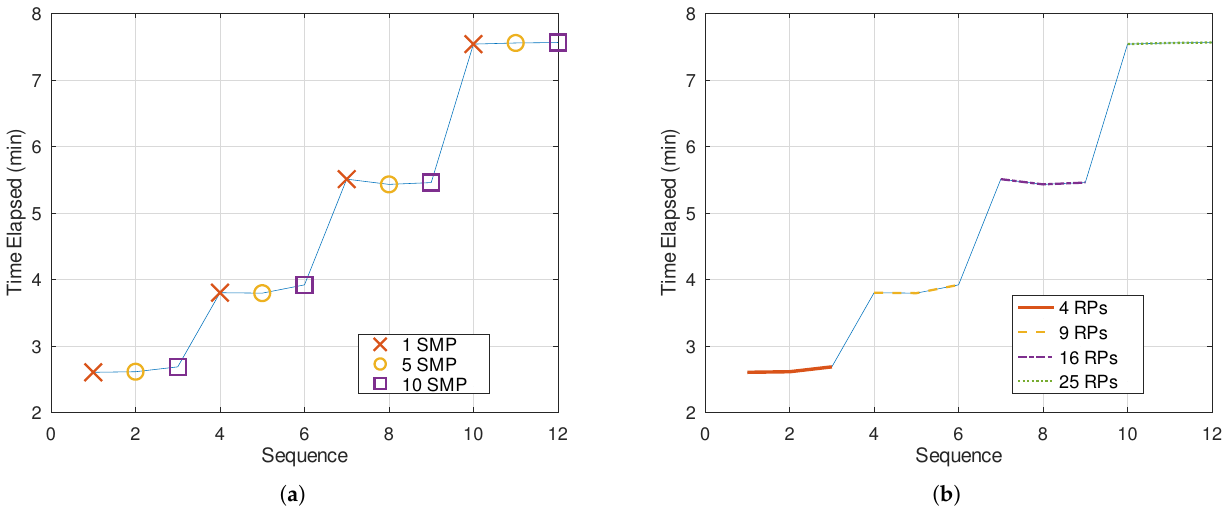
Figure 10. Time elapsed for each sequence: ( a ) Influence of samples per test; ( b ) Influence of